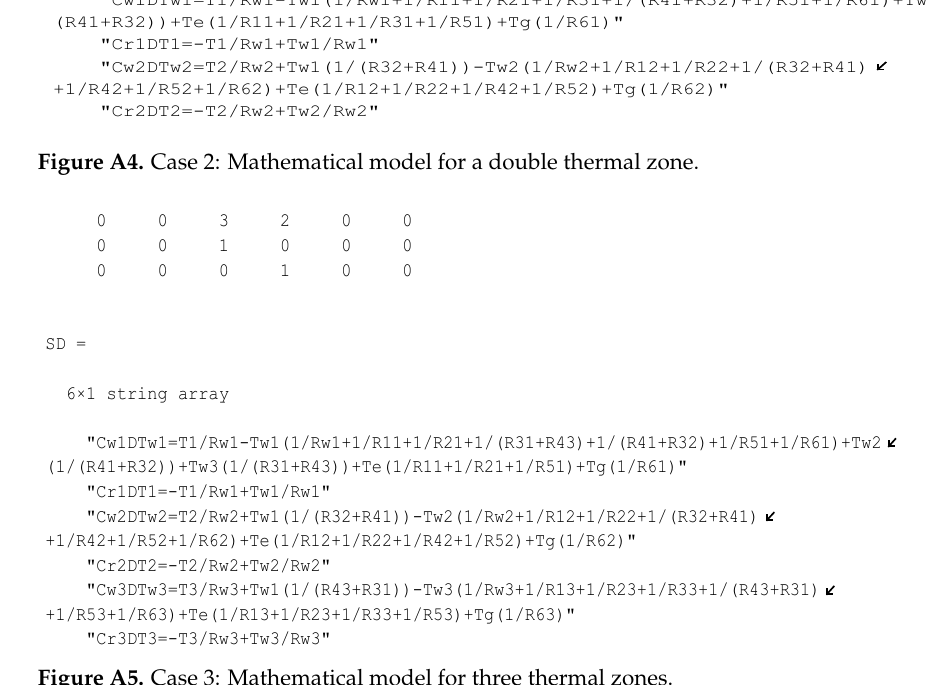
Figure A5. Case 3: Mathematical model for three thermal zones. >>